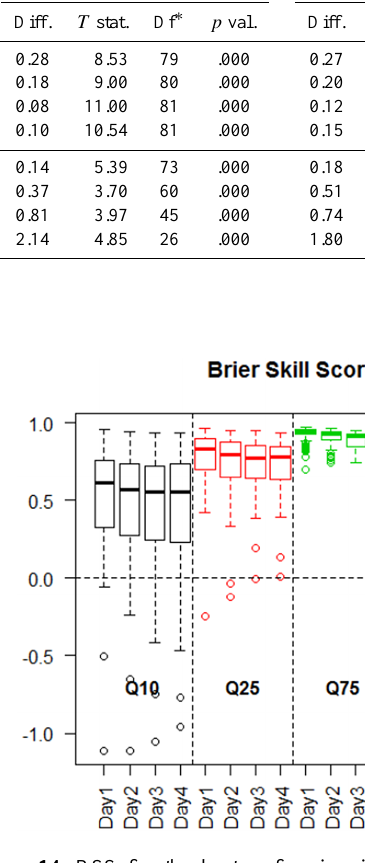
Figure 13. BSS for the forecast-only configuration for different lead times and event thresholds. The BSS’ perfect score equals one. A BSS of zero indicates a forecast without skill.